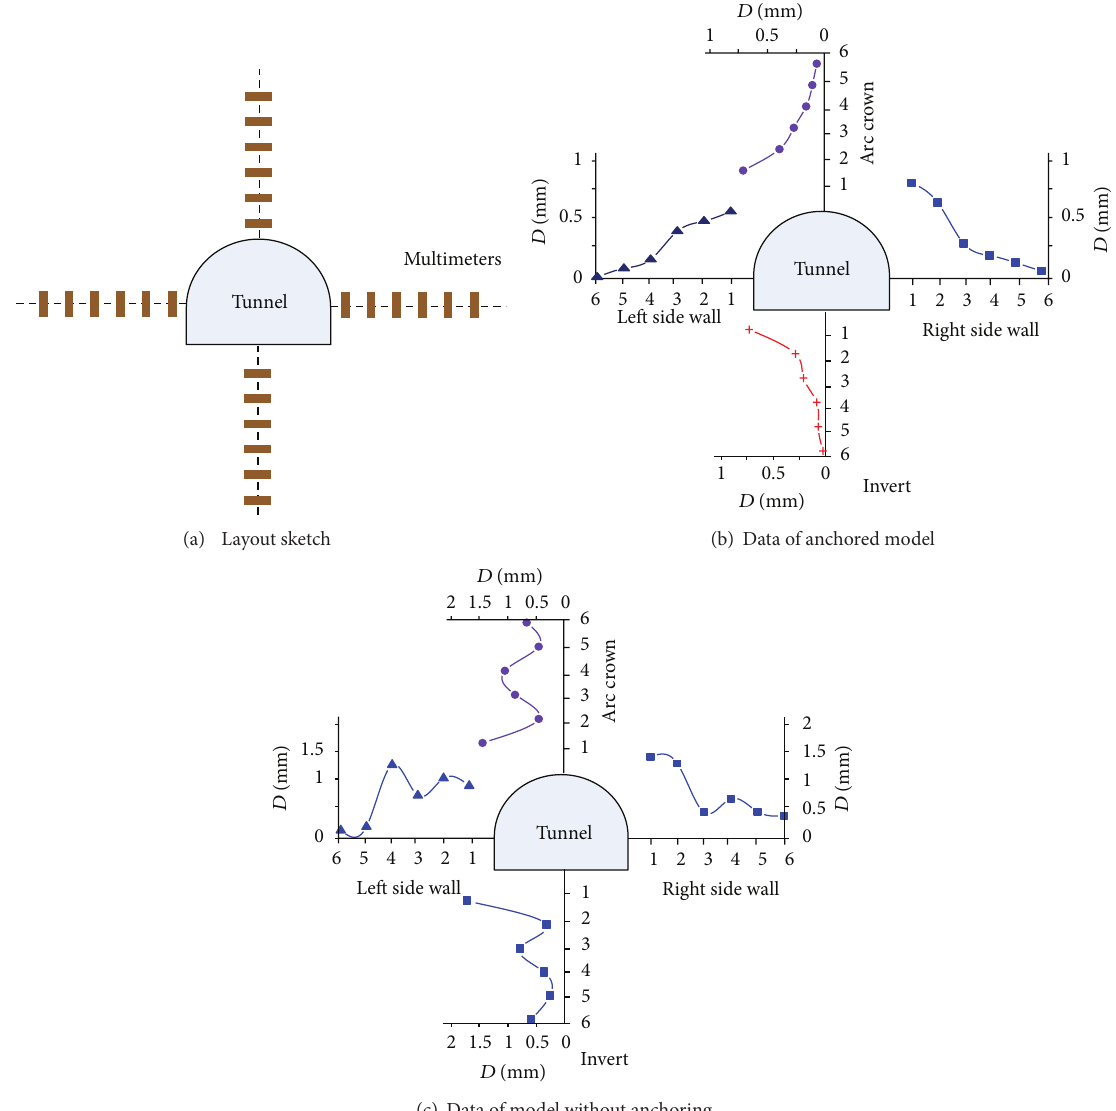
Figure 15: Displacement surrounding the model